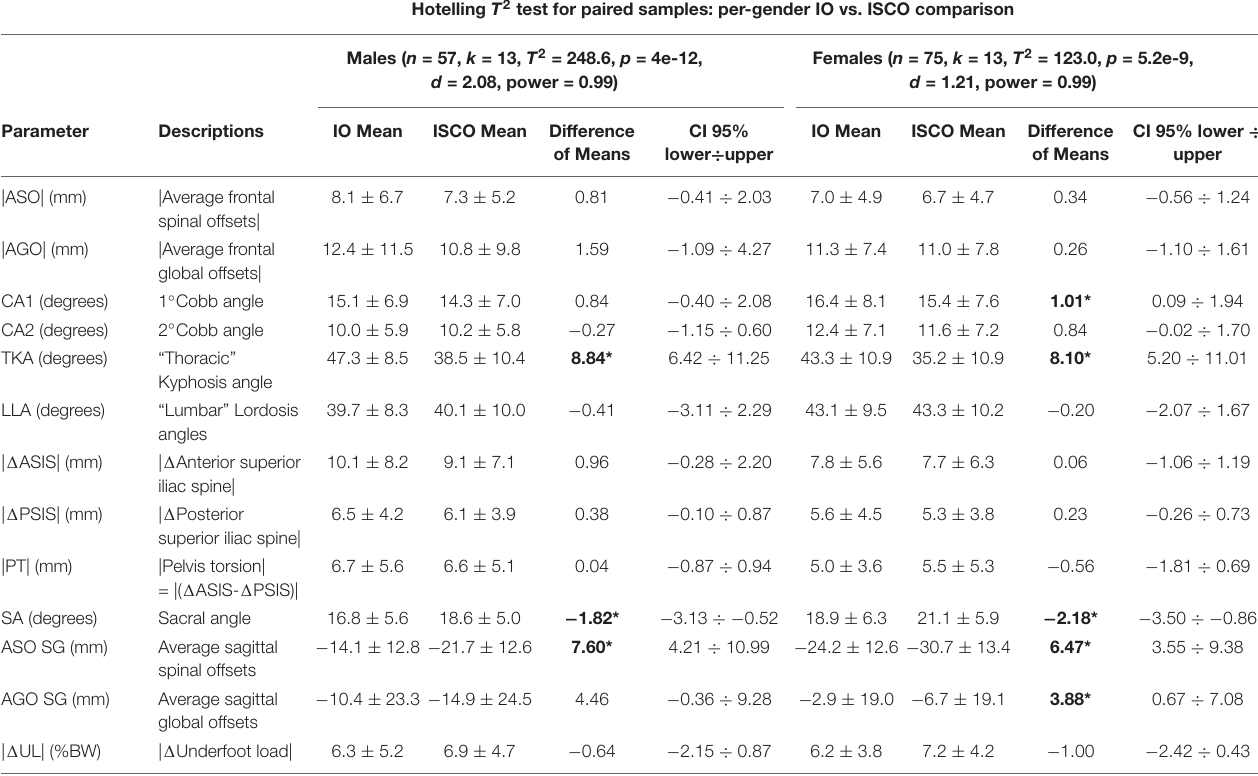
TABLE 4 | Per-gender IO vs. ISCO comparisons in AIS patients: Hotelling T 2 tests results, 95% confidence intervals, and difference of means. Hotelling T 2 test for paired samples: per-gender IO vs. ISCO